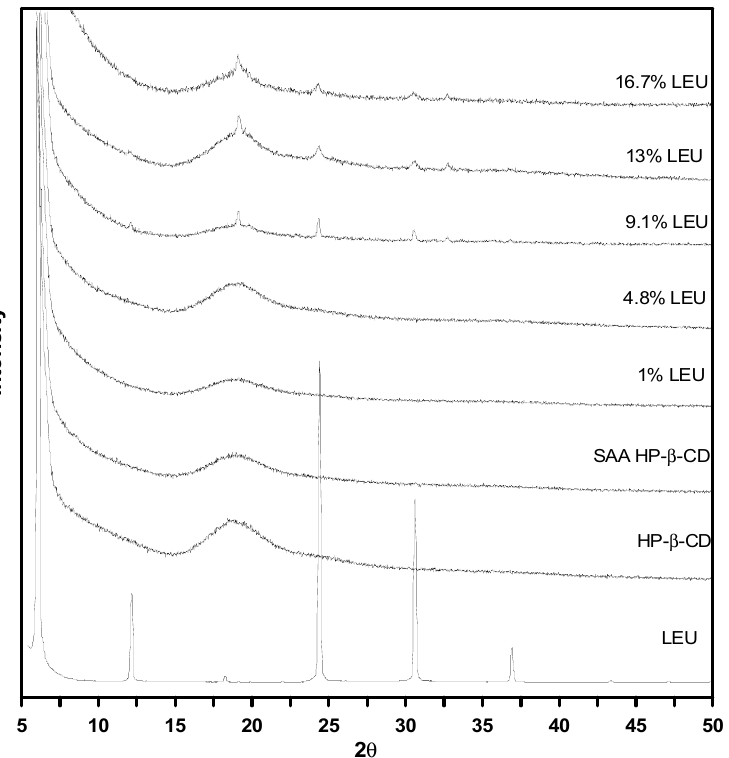
Figure 7. XRD patterns of the HP- β -CD carrier particles with varying amount of LEU (mass%) produced through SAA.